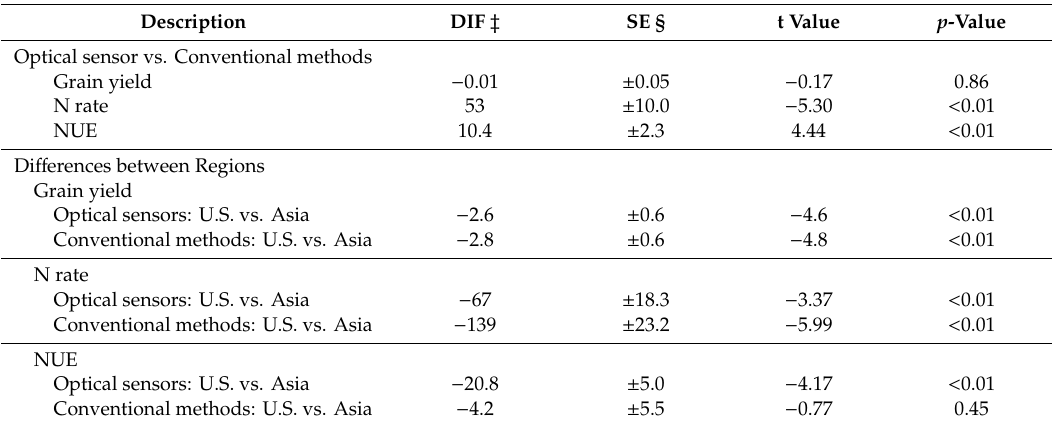
Figure 3. Winter wheat rain yield for optical sensor and conventional methods of N management for the U.S. and Asia. Table 3. Evaluation of the di ff erences in grain yield, nitrogen use e ffi ciency (NUE) and nitrogen (N) rate that occurred between active optical sensors and conventional methods of N management as well as regional di ff erences using paired t-test (unpaired t-test for regional di ff